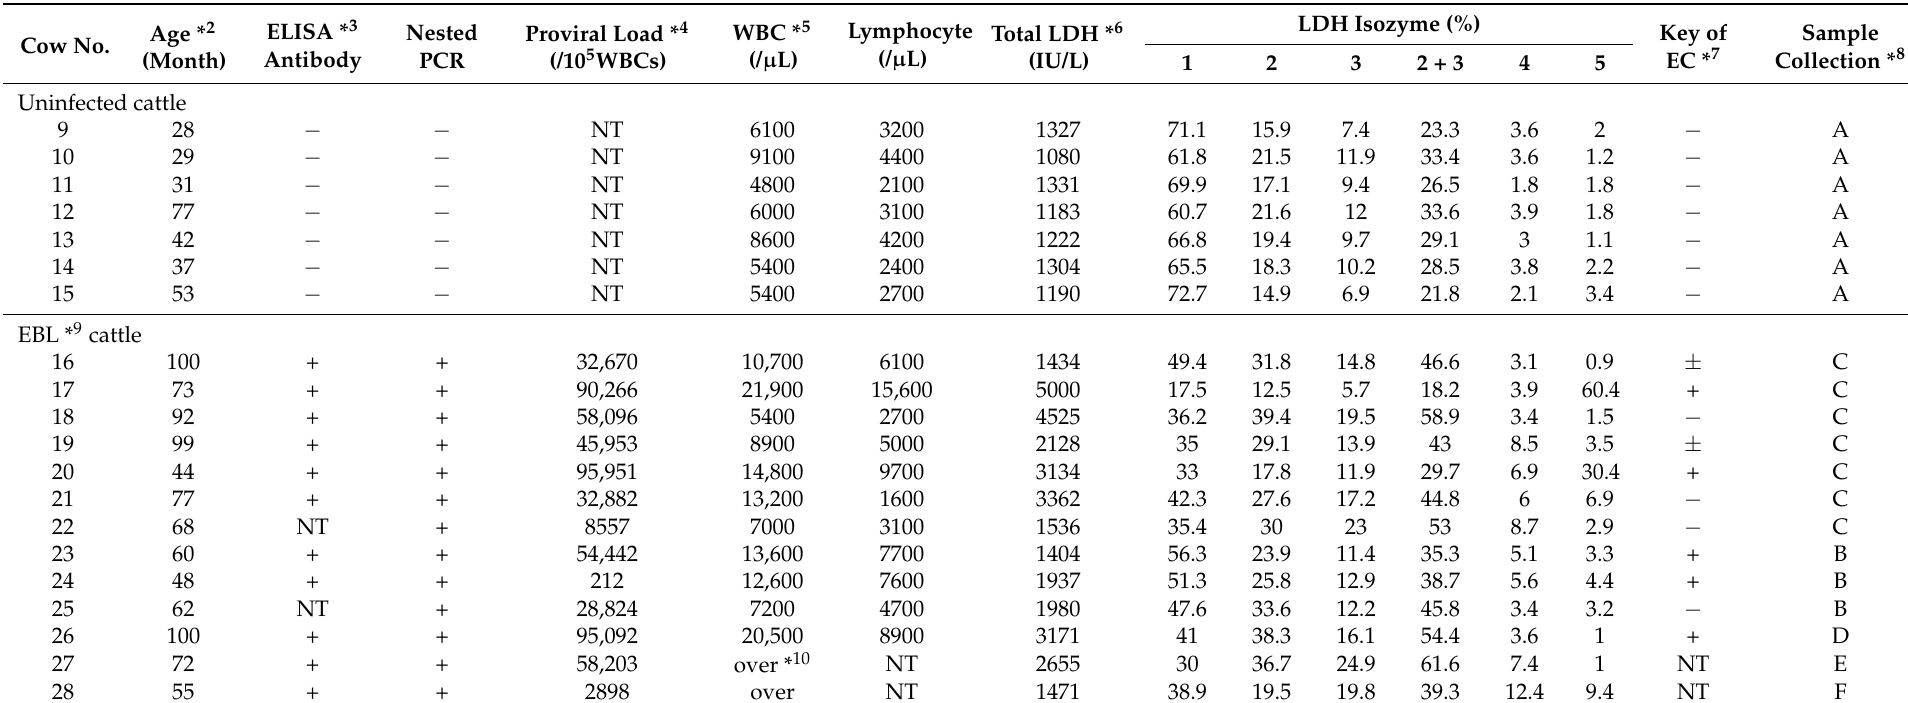
Table 2. BLV infection and clinical status of cattle used for evaluation of candidate miRNA biomarkers using qPCR * 1 . Cow